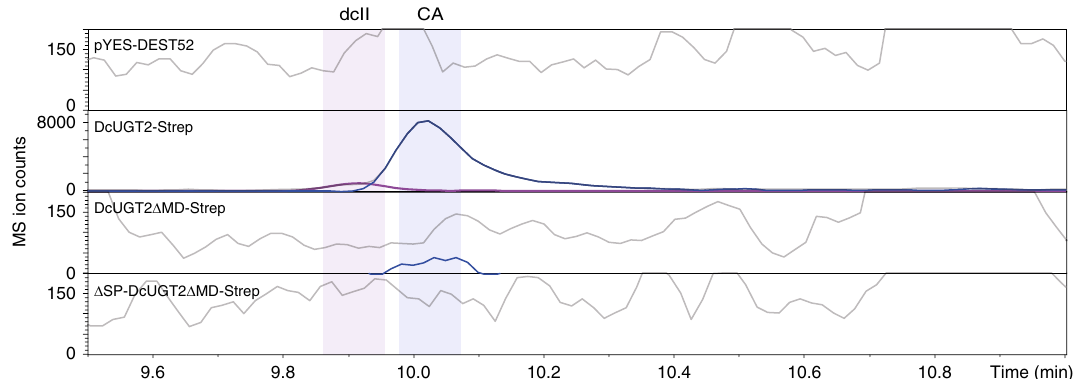
Fig. 10 Activities of different DcUGT2-Strep forms synthesized in yeast. Yeast microsomes containing pYES-DEST52, DcUGT2-Strep, DcUGT2 Δ MD-Strep and Δ SP-DcUGT2 Δ MD-Strep were incubated with UDP-glucose and a Kermes vermilio metabolite fraction, containing kermesic acid and fl avokermesic acid. Assay products were analyzed by LC-ESI( − )-MS and ion chromatograms of m/z 475.0882 (purple) and 491.0831 (blue) were extracted, corresponding to dcII and carminic acid (CA),